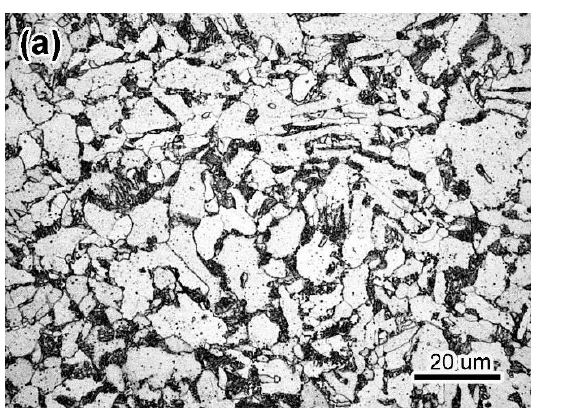
Figure 1. The microstructure of the experimental steel after ( a ) annealing and ( b ) standard heat treatment (quenching + tempering).